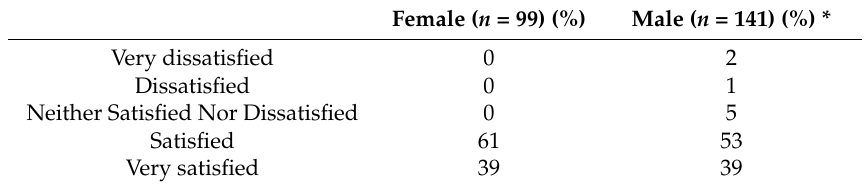
Table 2. Satisfaction with the canteen food for female and male participants,